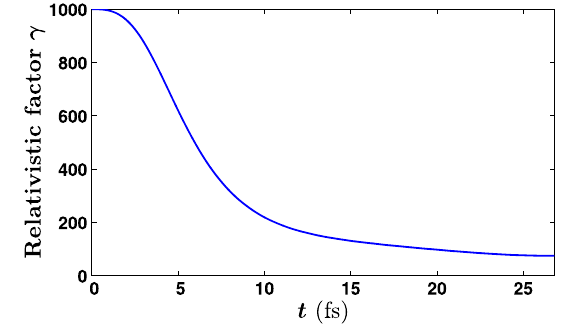
¼ 100 , and a pulse- 0